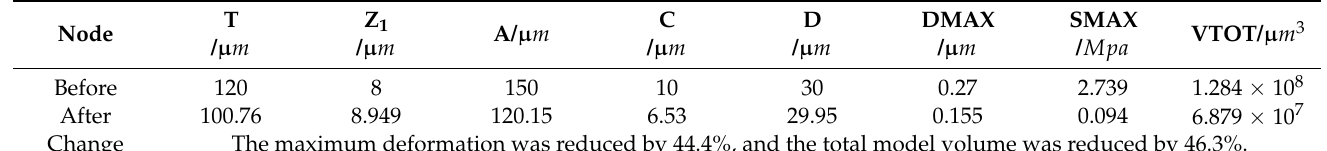
Table 4. Comparison of cell microstructure before and after